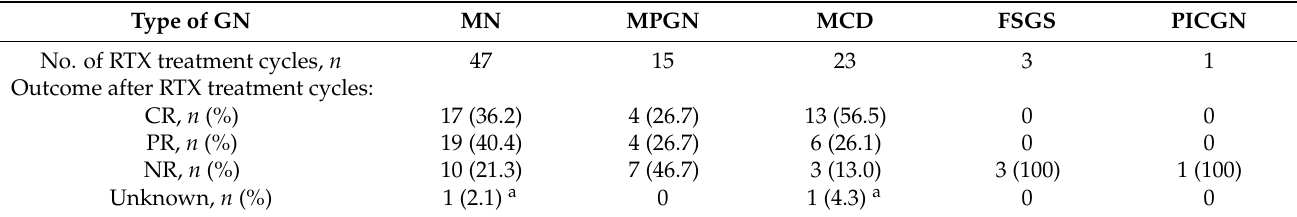
Table 3. Observed outcome after each rituximab treatment cycle.